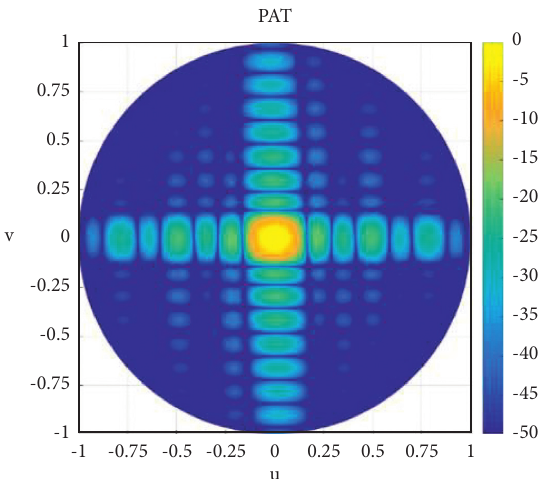
Figure 15: Position error pattern changes of the left and right half arrays in the XY -direction ( 0 . 1 λ ) .